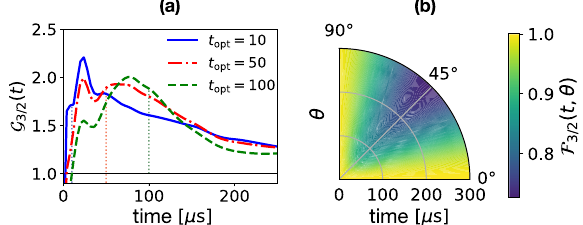
Fig. 5 Optimization time and initial states. a Gain as a function of time for a logical state ψ L j i ¼ ð 0 L j i þ i 1 L j iÞ = codewords optimized at three different times t opt = 10, 50, 100 μ s and S = 3/2. b Fidelity (colour scale) as a function of time (radial scale) for different initial superposition states cos θ 0 L j i þ isin θ 1 L j i ( θ depicted in angular scale) of a set of optimized numerical codewords for S =